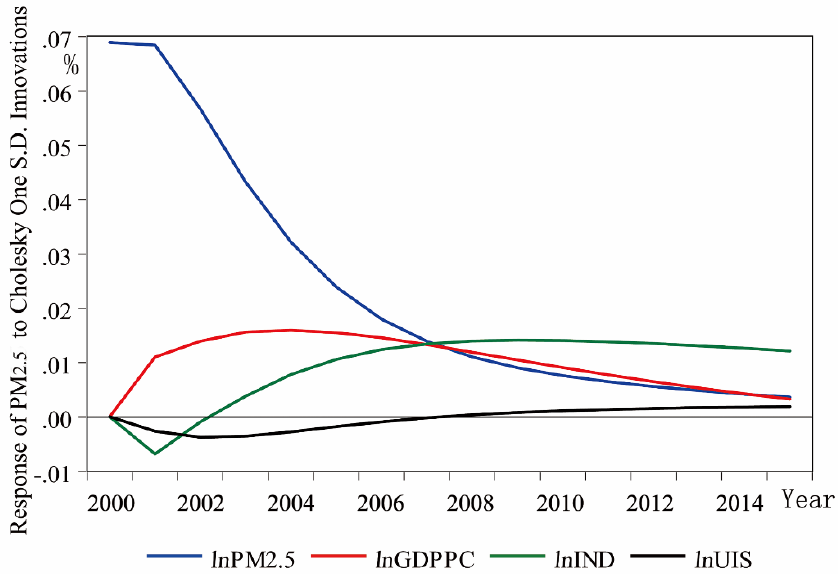
Figure 6. Results of the impulse response of ln PM 2.5 to Cholesky one S.D. innovations of the variables.